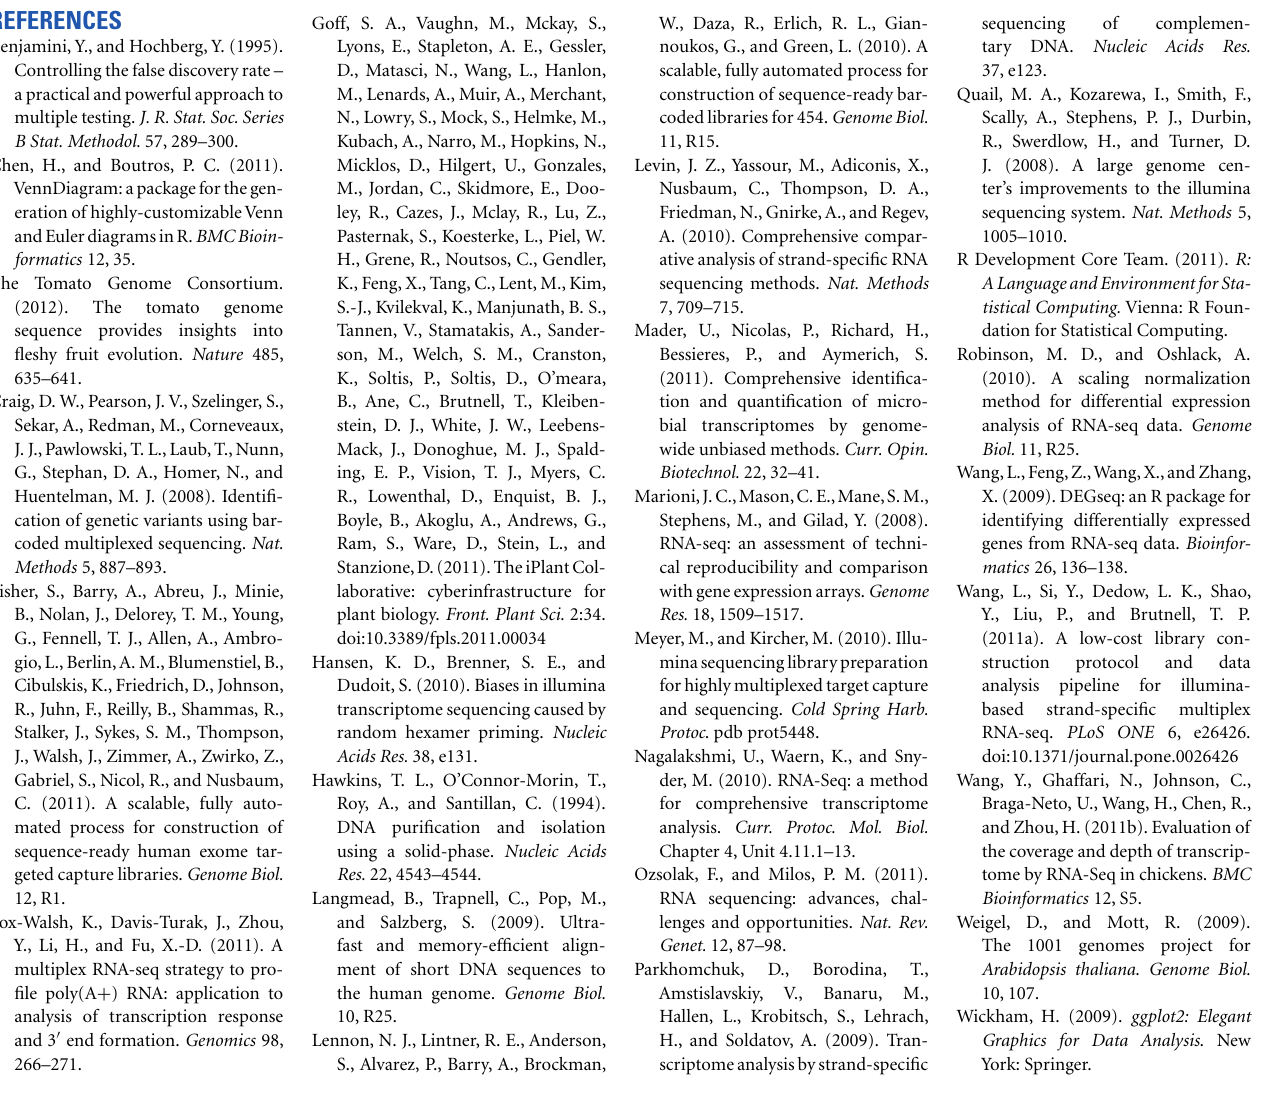
Table S4 | Percent reads for each library post processing. Table S5 | Read counts for various DE categories. Table S6 | Comparison of differentially expressed gene sets between different